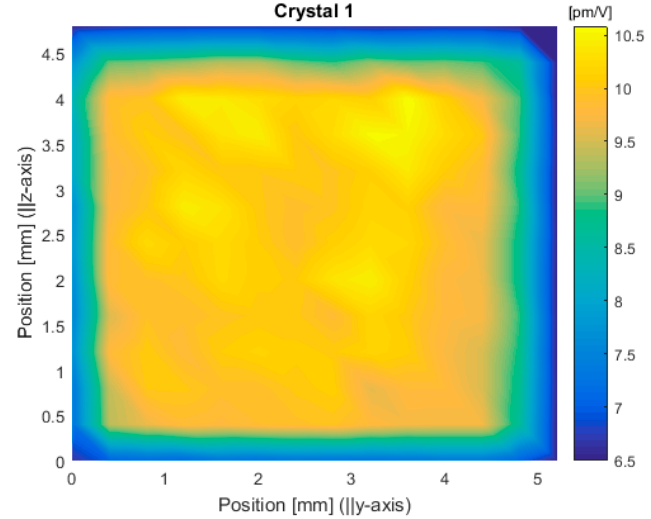
Figure 11. Map of the effective nonlinearity d eff across the aperture of the PPKTP crystal.